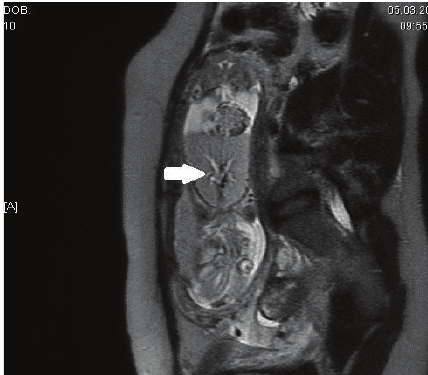
Figure4:Antenatalsonographyofcase2showinglargehyperechoic lungs(a),dilatedmainbronchi(b),largehyperechoiclungs,inverted diaphragm, and